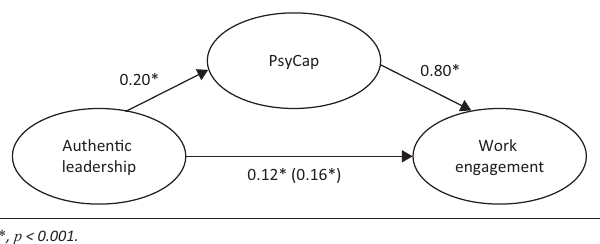
FIGURE 1: Indirect effect of authentic leadership on work engagement through psychological capital. PsyCap, psychological capital.